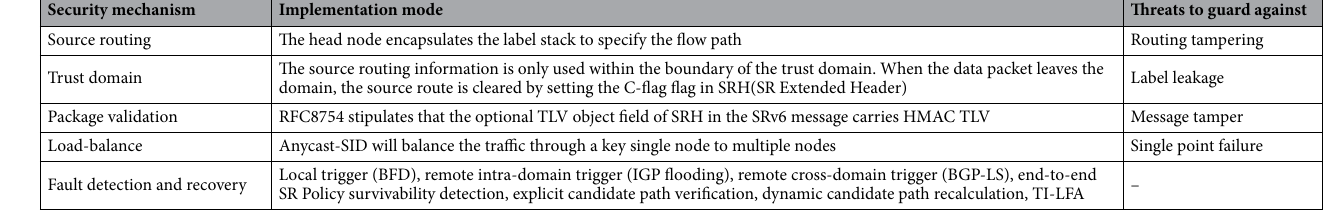
Table 1. SR native security